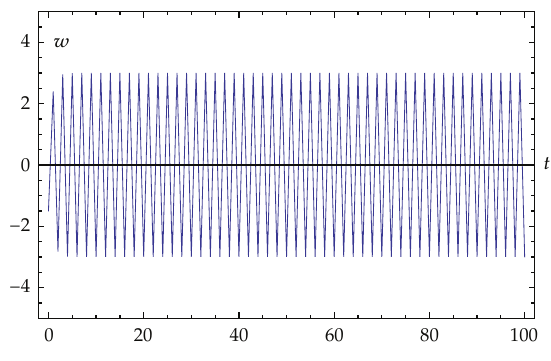
Figure 4: Trajectory of excess demand w t when χ 1 (cid:7) − 4.